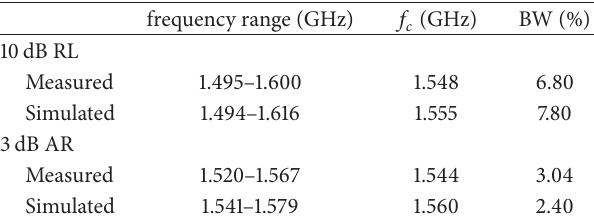
Figure 10: Measured and simulated radiation patterns at 1.55 GHz. Table 3: Measured and simulated 10dB RL and 3 dB AR frequency range and bandwidths.